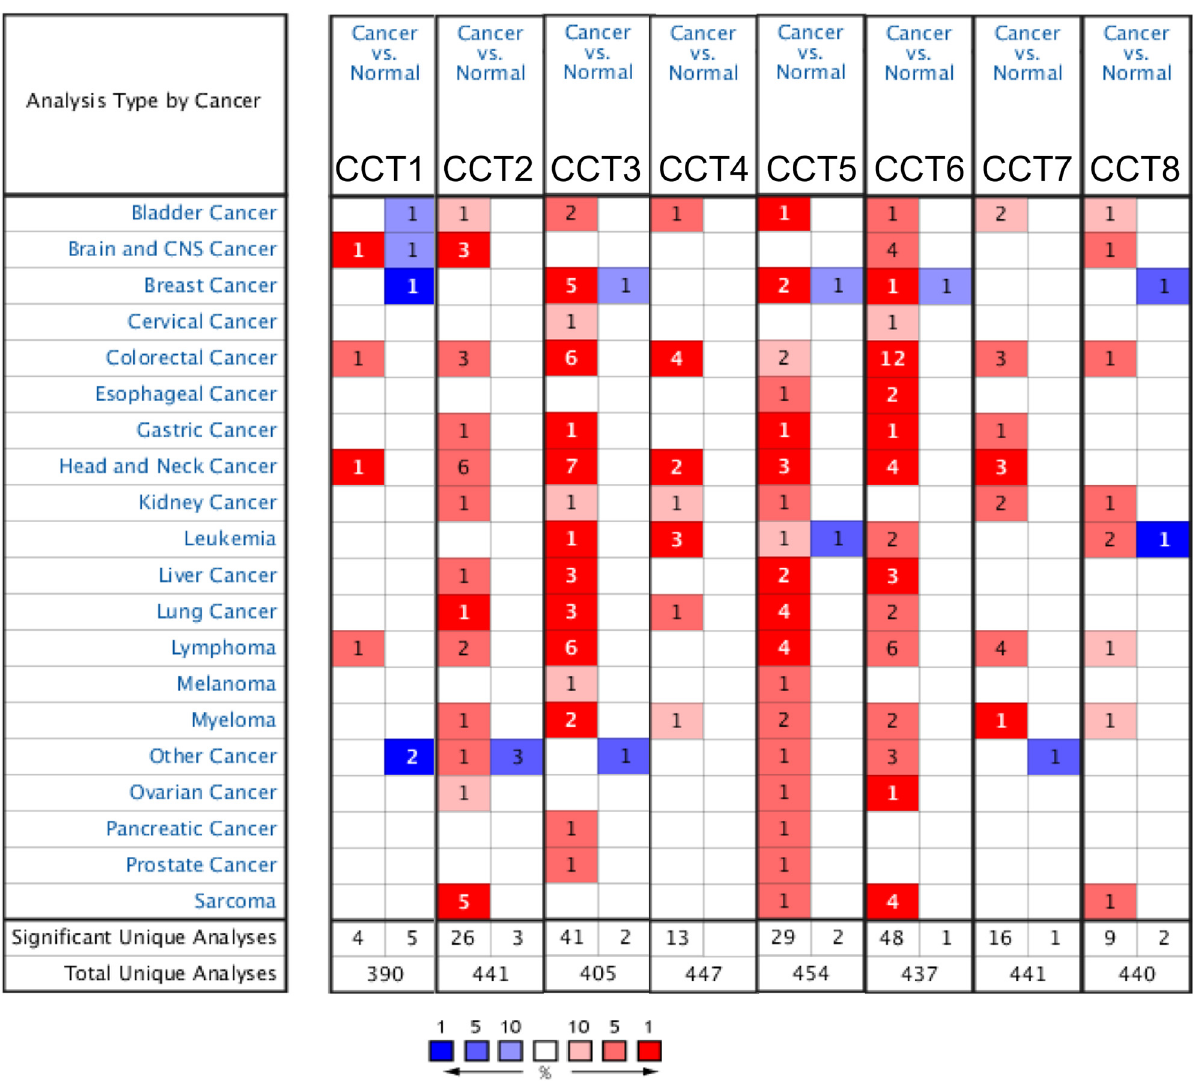
Figure 1: The mRNA transcriptional levels of CCTs in di ff erent types of cancers ( ONCOMINE ) . This graphic was generated from ONCOMINE, indicating the numbers of datasets with statistically signi fi cant ( P < 0.0001 ) mRNA overexpression ( red ) or downexpression ( blue ) of CCTs ( di ff erent types of cancers vs corresponding normal tissue ) . Cell color was determined by the best gene rank percentile for the analyses within the cell, and the gene rank was analyzed by the percentile of target gene in the top of all genes measured in each